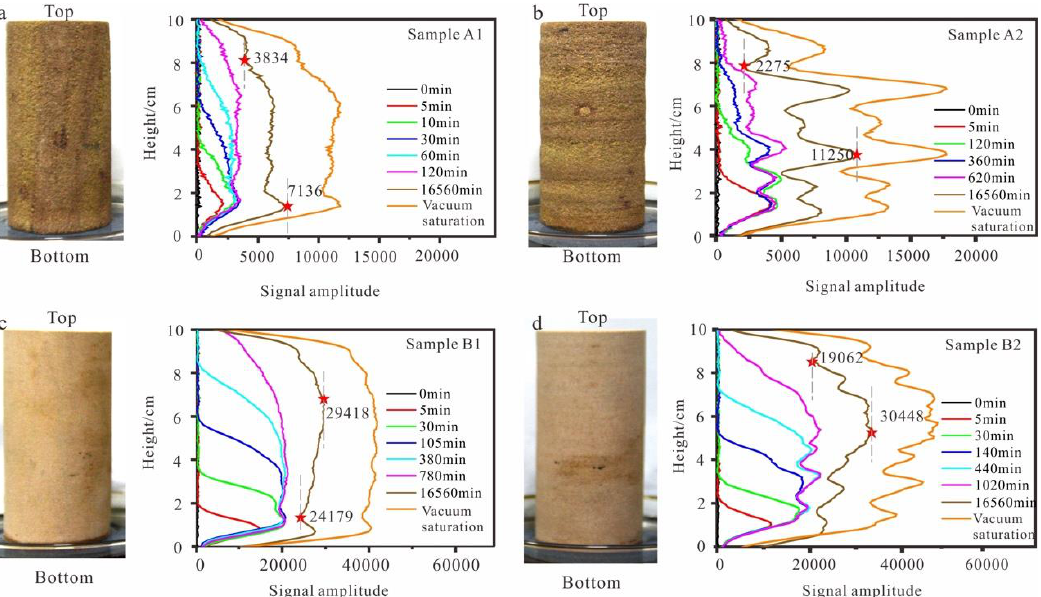
Figure 7. Stratified moisture distribution curves during the capillary imbibition process in ( a ) Sample A1; ( b ) Sample A2; ( c ) Sample B1 and ( d ) Sample B2.